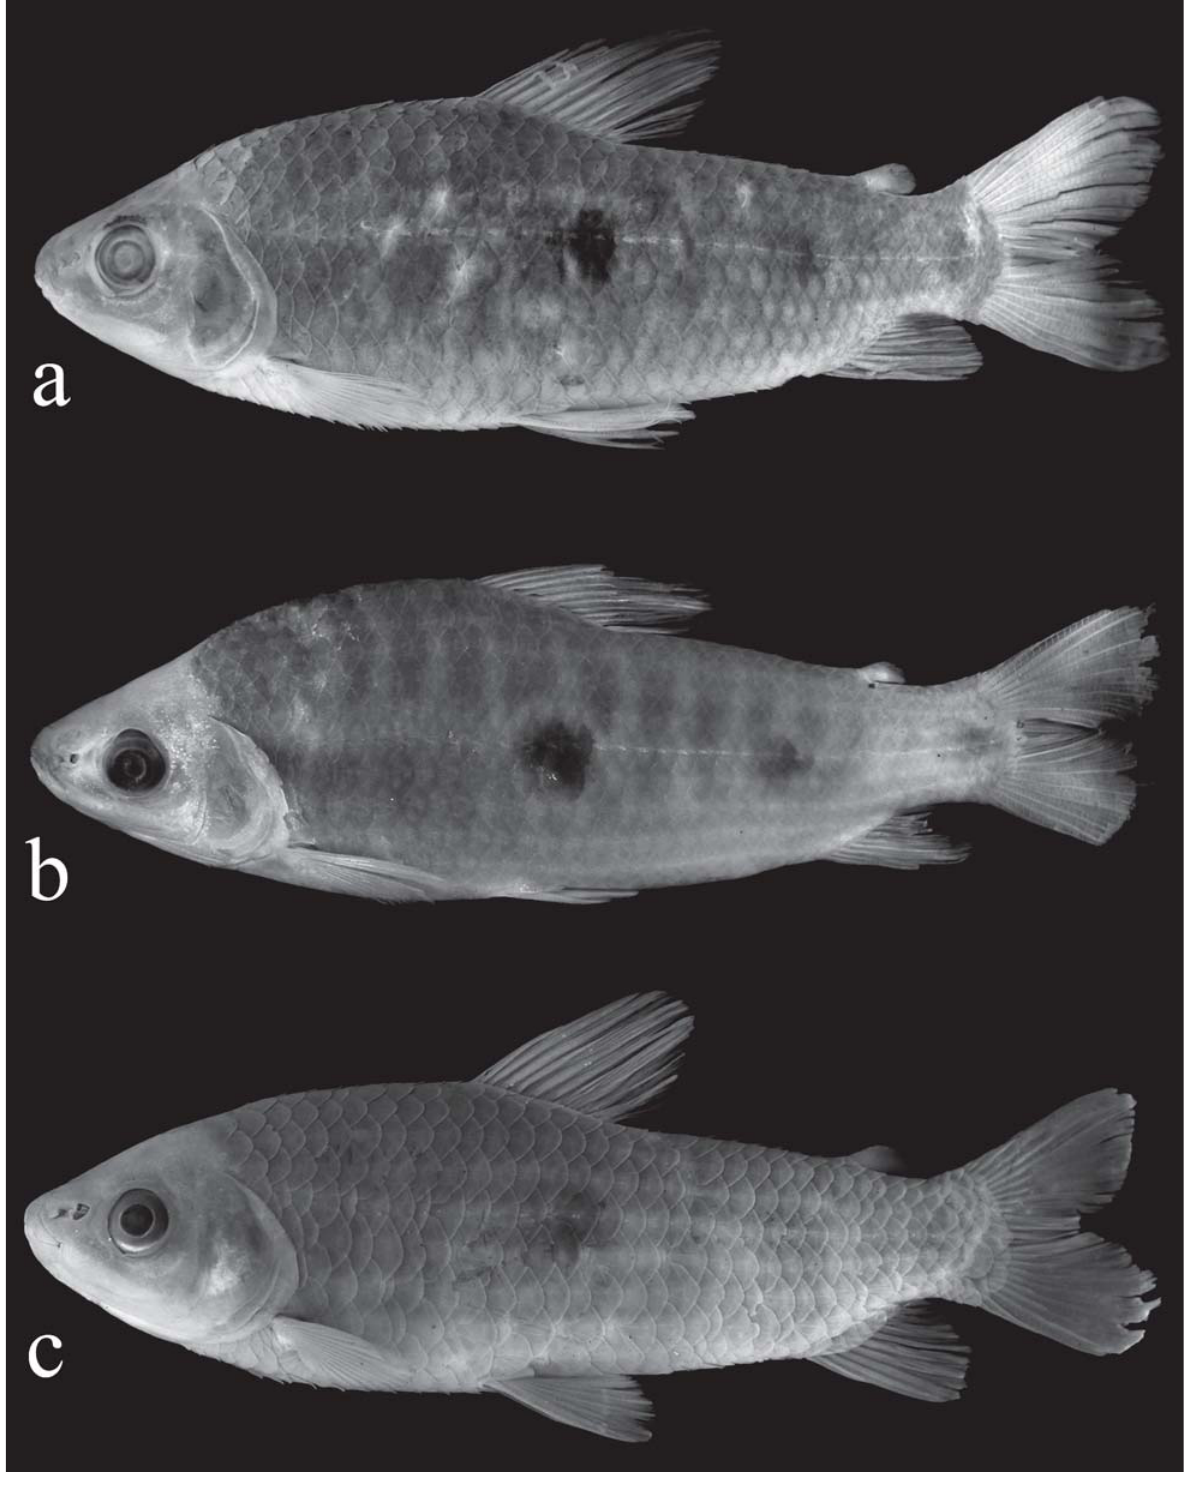
Fig. 1. Photograph in lateral view of (a) Leporinus venerei (holotype, MZUSP 93124, 113.3 mm SL), (b) Leporinus parae (MZUSP 48445, 111.9 mm SL), and (c) Leporinus lacustris (MZUSP 48414, 95.0 mm scales from dorsal-fin origin to lateral line and 4.5 (6) to 5* tween dorsal fin and adipose fin; 7* or 8 scales in median (15) scales from lateral line to pelvic-fin base; 9, 10* or 11 dorsal row between adipose fin and caudal fin; 14 to 18* predorsal scales; 10 to 12* scales in median dorsal row be- prepelvic scales; 9, 10* or 11 scales in median ventral row